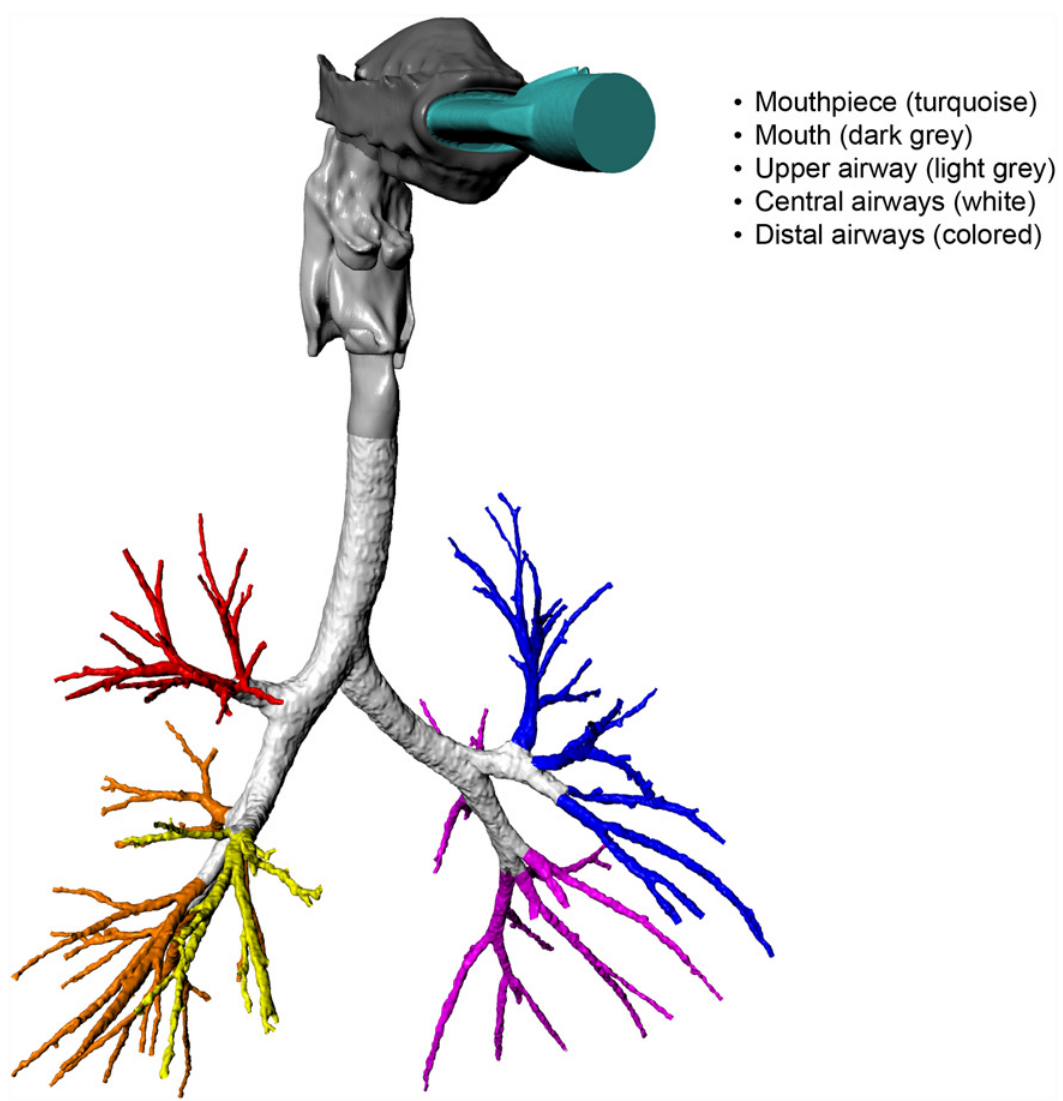
Fig 1. Coupled mouthpiece/upper/lower airway model. Coupled mouthpiece/upper/lower airway model subdivided in multiple regions. Airways are segmented up to the 5 th -9 th generation.